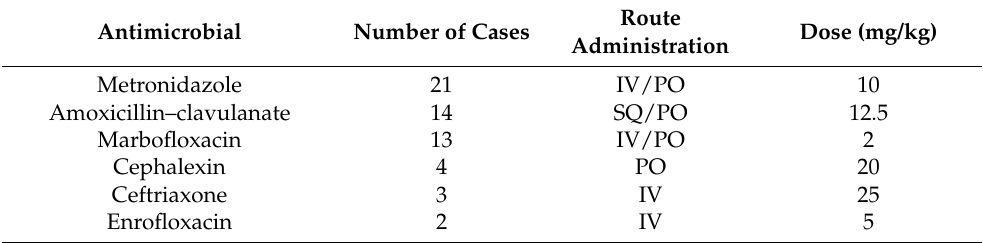
Table 9. Summary of the details of antimicrobial administration in 28 cats with pyothorax.